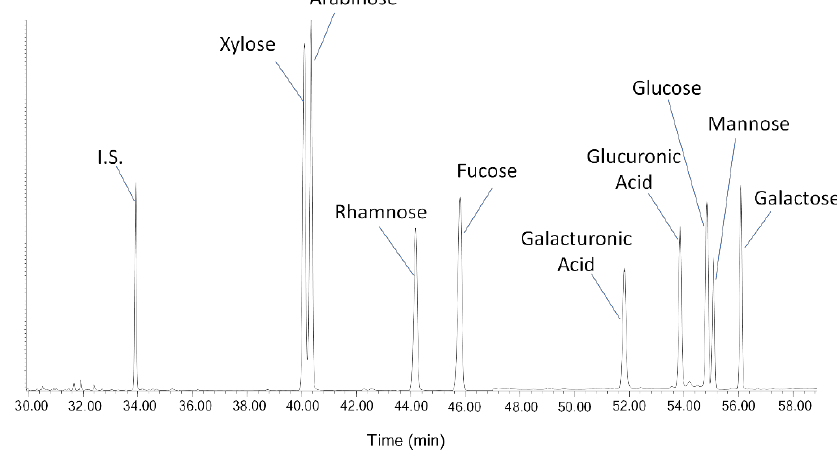
Figure 1. GC-MS chromatogram in SIM mode of a standard sugar solution of 7 monosaccharides and 2 uronic acids (each at 10 ppm), where I.S internal standard—Mannitol (10 ppm).